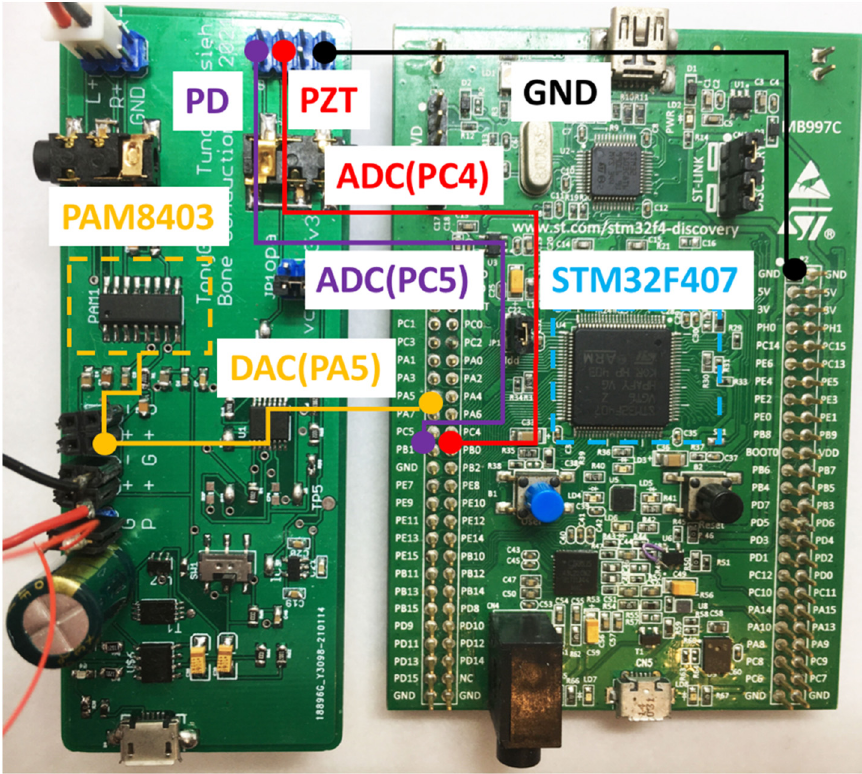
Figure 16. Connection between the laser audio receiver and the STM32F407 processor.